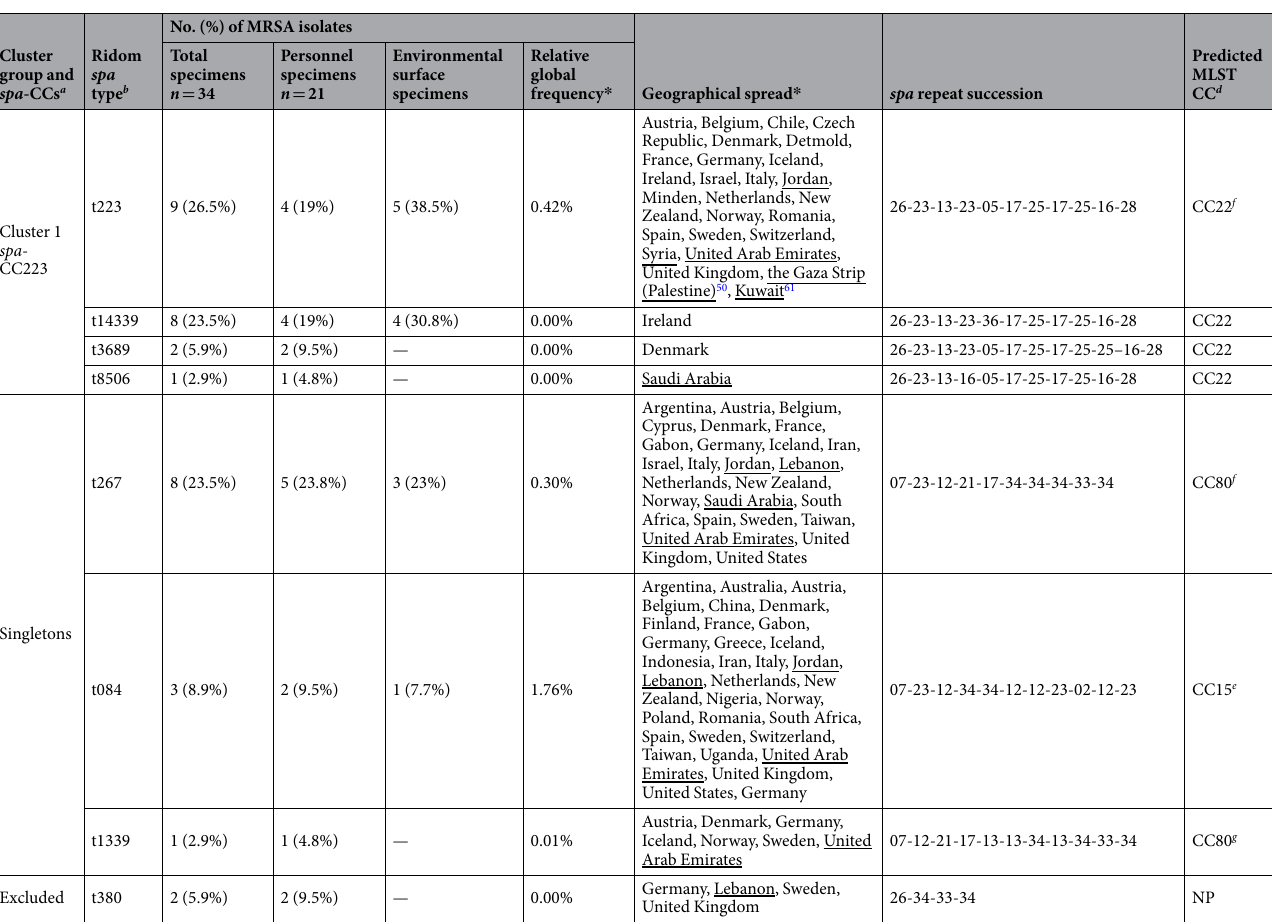
Biofilm formation. From the 34 MRSA isolates tested for biofilm formation, 8 (23.5%) isolates were classified as strong biofilm producers, 10 (29.4%) were moderate, 7 (20.6%) were weak, and 9 (26.5%) were non-biofilm producers (Fig. 2). This classification was based on the criteria established by Stepanovic and colleagues 34 . All isolates from personnel were shown to be moderate, weak, or non-biofilm producers, except two isolates with strong biofilm-forming ability (Table 2, IDs: 7 and 93), which were derived from hand and nasal swabs of two different patients attending the prosthetic dentistry and prosthodontic wards, respectively. For isolates recov- ered from enviromental surfaces, only 7.7% (1/13) of the isolates were non-biofilm formers, while the rest were biofilm formers [46.2% (6/13) strong, 23% (3 /13) moderate, and 23% (3/13) weak] (Fig. 2). There was no statistically significant difference in biofilm-forming abilities between MRSA isolates recovered from personnel and those recovered from environmental surfaces ( χ 2 = 7.733, df = 3, P = 0.0519). Similarly, no significant differences were found in biofilm production between isolates recovered from clinical contact surfaces and those recovered from housekeeping surfaces ( χ 2 = 2.829, df = 3, P = 0.4188). Discussion A very limited number of studies, none of which was performed in Egypt, investigated carriage frequency, anti- biotic resistance, virulence properties, and genetic diversity of MRSA strains isolated from personnel and envi- ronmental surfaces from dental health-care personnel (DHCPs), dental patients, and dental environment. In an effort to fill this knowledge gap, we phenotypically and genotypically characterized MRSA isolates from six